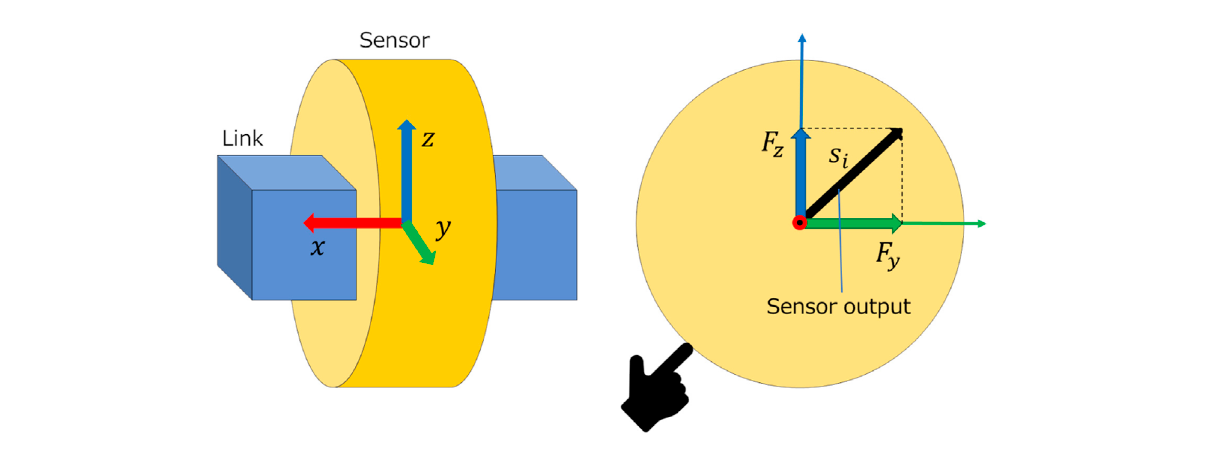
FIGURE 2 Model of tactile sensor.